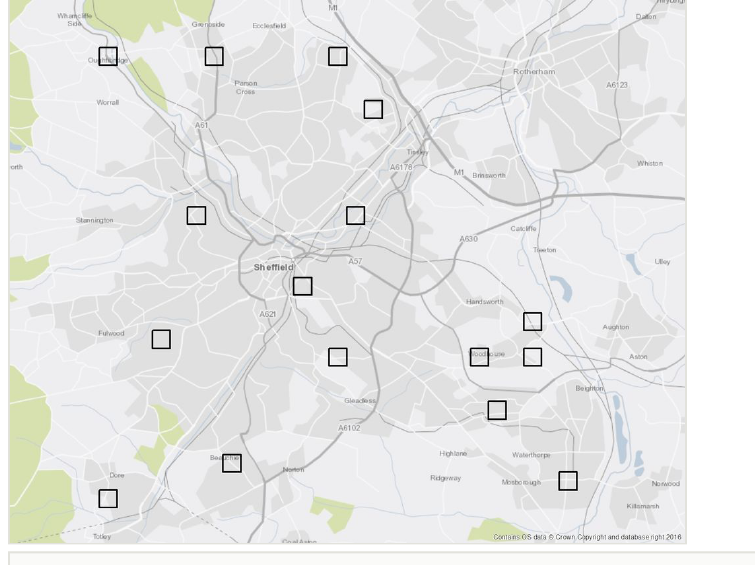
Figure 1. The 16 500 x 500 m sub-cells sampled in She ffi eld during this urban recording project. The shape fi le is available in (Suppl. material